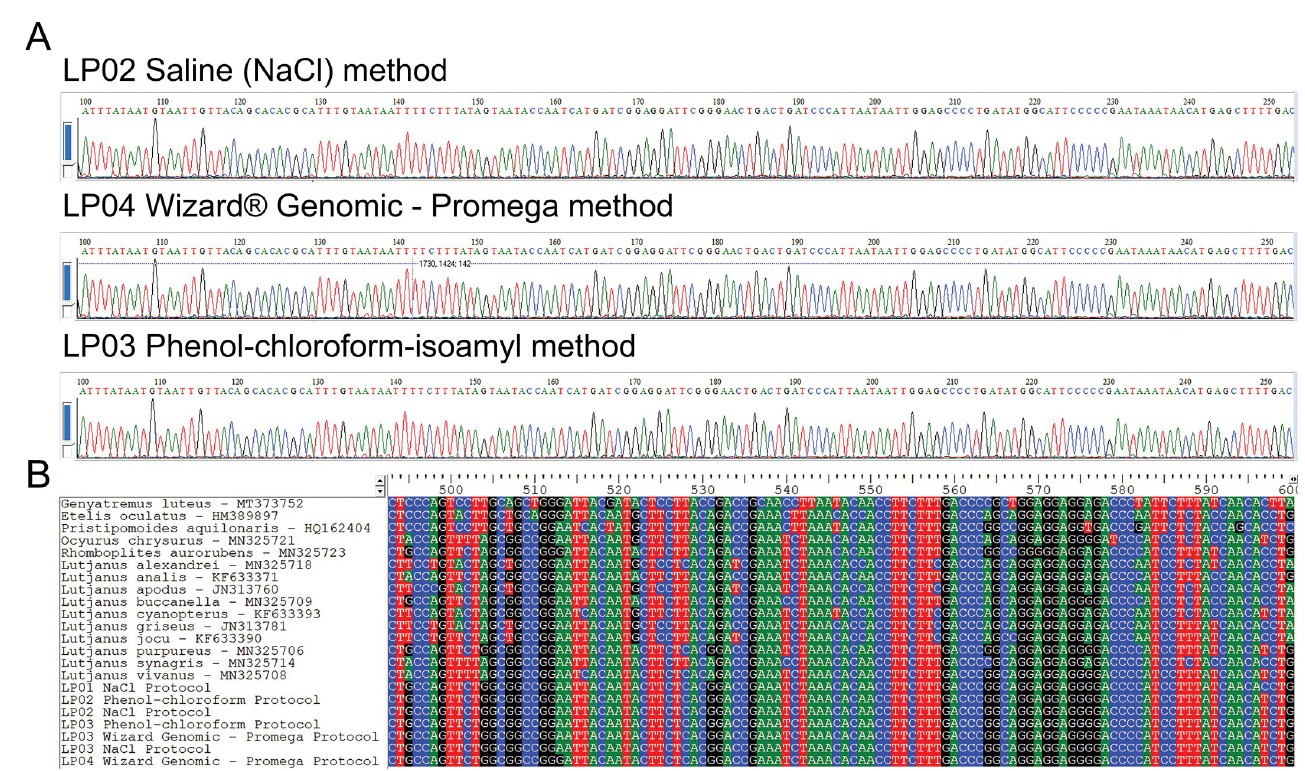
Fig 4. Portions of COI sequences from L . purpureus according to each DNA extraction method. LP: Lutjanus purpureus . A: Electropherograms in three samples of red snapper. B: Sequence dataset encompassing the seven COI sequences in a pilot essay with L . purpureus and other Lutjanidae representatives from the Brazilian coast. The species Genyatremus luteus (Haemulidae) was used as an outgroup.